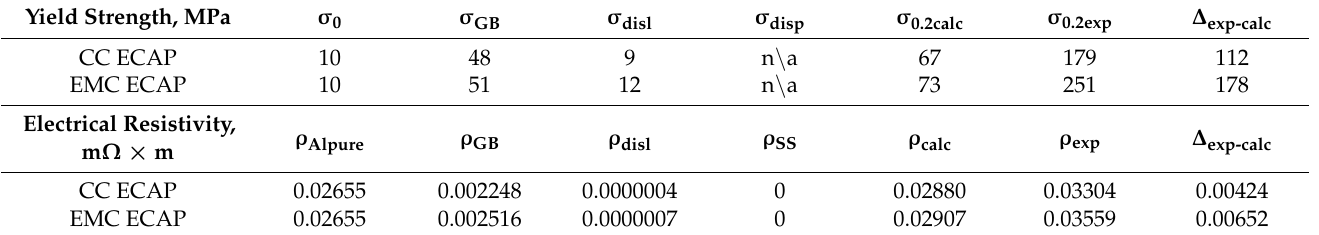
Table 6. Contribution of structural mechanisms to the strength and electrical conductivity of CC and EMC